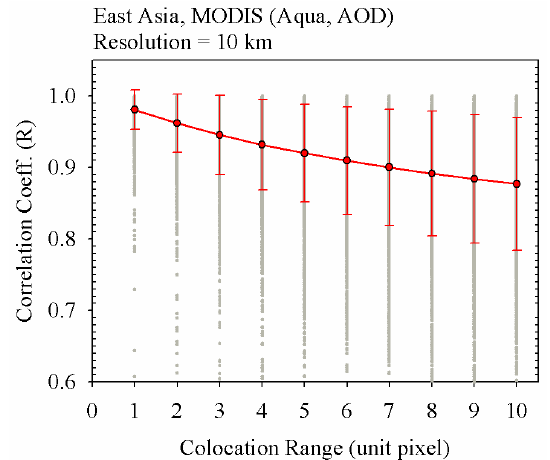
Figure 4. Distribution of correlation coefficient (R d ) for AOD in East Asia with respect to the colocation range.